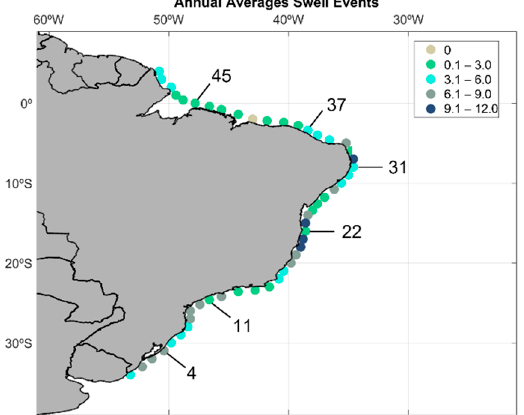
Figure 8. Annual mean number of swell events for Brazil, and the location of the six key points. Table 3. Percentages of the number of swell events (%) originating in each area of the Atlantic Ocean: North Atlantic Ocean (NATL), Tropical Atlantic Ocean (TAO), and South Atlantic Ocean (SAO). Point NATL TAO SAO Atlantic Swells 45 97.6 0.8 0.0 98.4 37 89.4 2.5 0.0 91.9 87.9